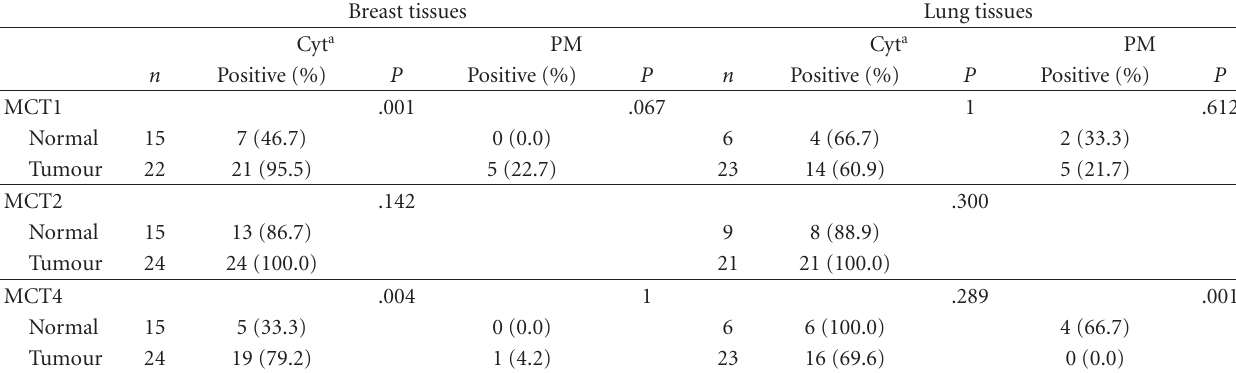
Table 2: Frequency of MCTs expression in nonneoplastic and malignant breast and lung